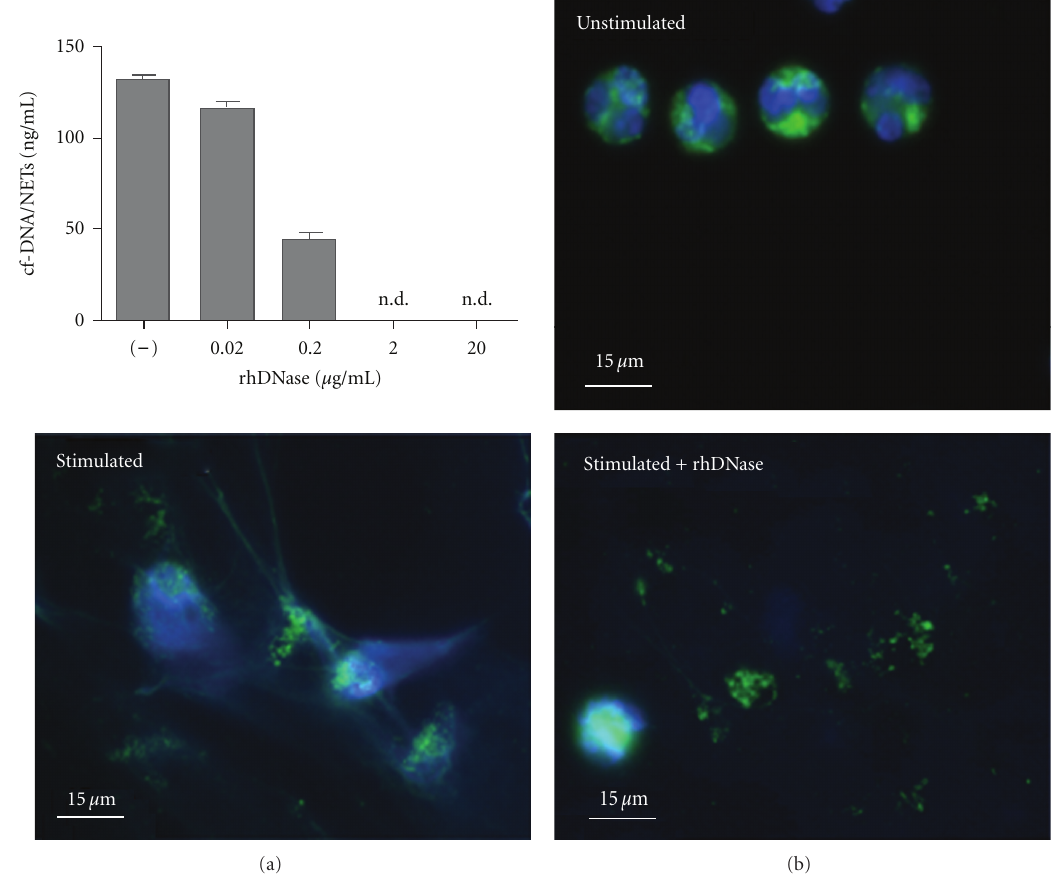
Figure 4: Degradation of NETs by DNase in vitro. (a) Degradation of NETs in a concentration-dependent manner. Neutrophils were isolated from healthy volunteers ( n = 5) and stimulated 3h with 50nM PMA. Then, the supernatants were incubated with 0, 0.02, 0.2, 2.0, and 20.0 µ g/mL rhDNase for 30 minutes and values of cfDNA/NETs were determined (n.d.: not detected). Data are presented as mean ± SEM. (b) Immunofluorescence staining of NETs. Neutrophils were stimulated with 30 nM PMA for 3h and stained for DNA (blue) and MPO (green). Cells were further incubated with 20 µ g/mL